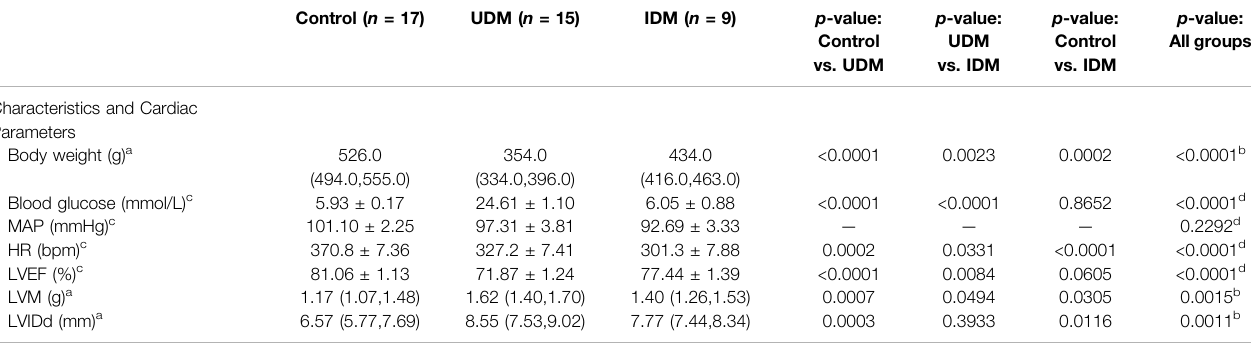
TABLE 1 | Characteristics and Cardiac Parameters at 14 weeks.